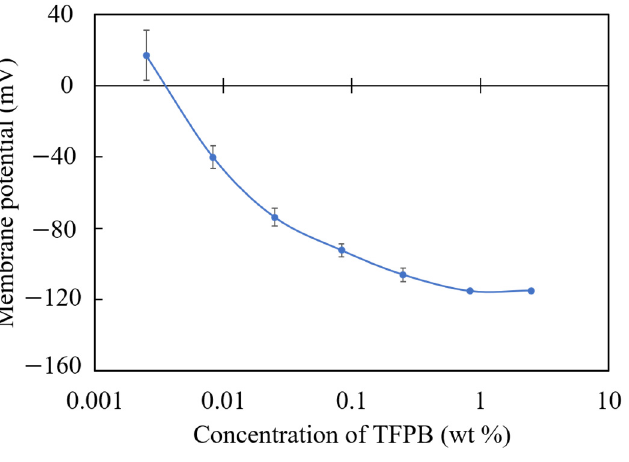
Figure 10. The membrane potential of TFPB-NPOE membranes with different TFPB contents. The results are expressed as means ± SD ( n = 16, 4 membranes × 4 times).